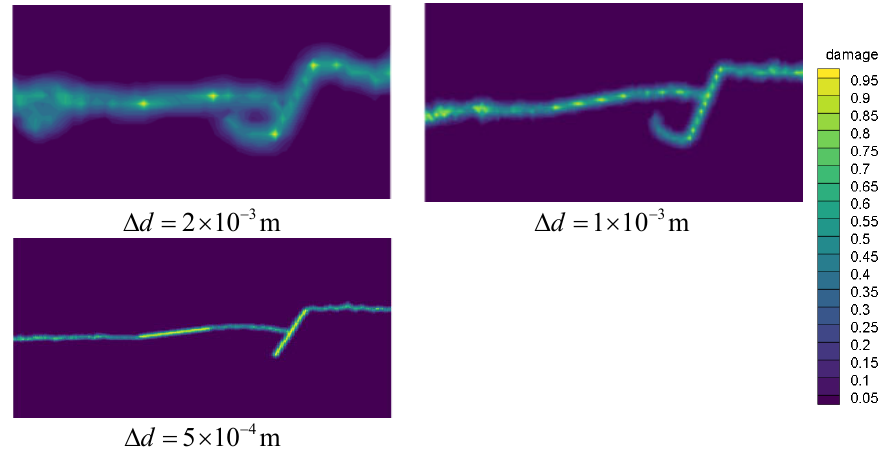
Figure 8. Crack path diagrams with different particle spacing.